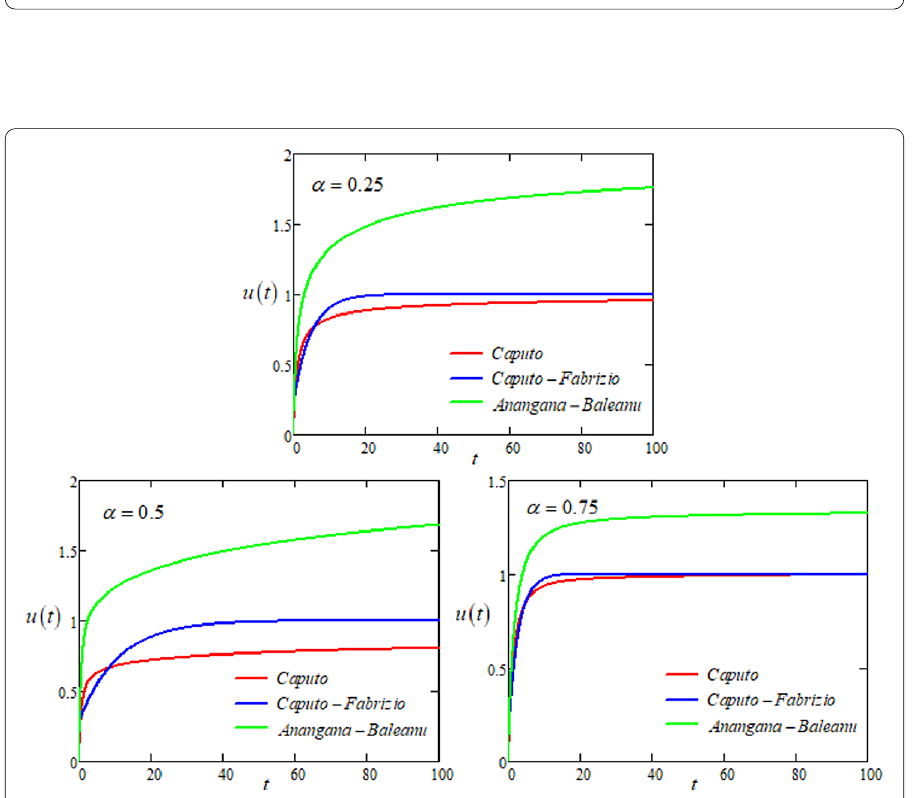
Figure 4 Comparison of profiles of velocity versus time for three definitions of fractional derivative operators with α =